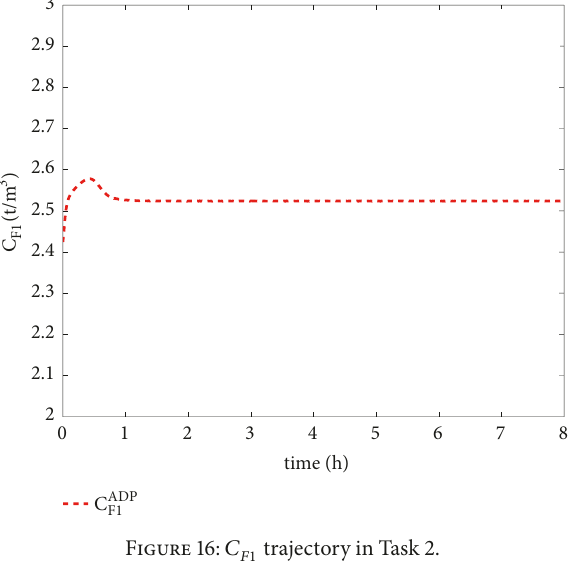
Figure 14: Iteration of the weighting variables for air flow rate in Task 1.